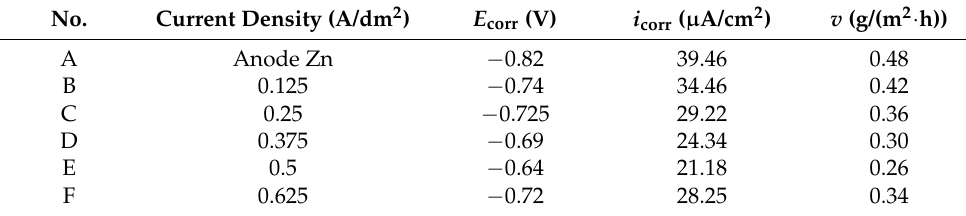
Figure 14. Tafel polarization curves of deposited Zn coating with different current densities. Table 2. Electrochemical polarization parameters of the coating with different current